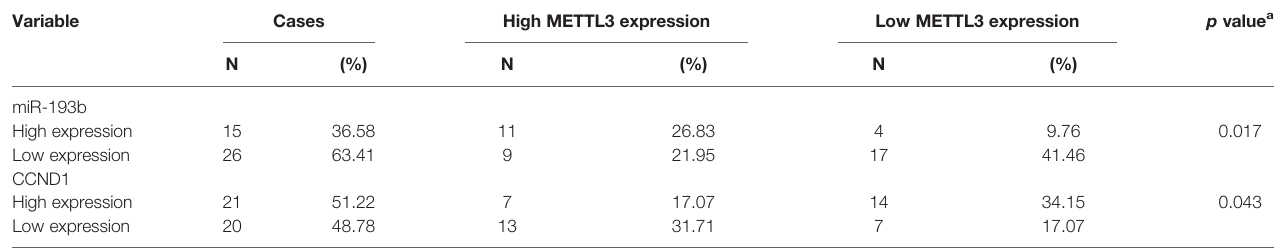
TABLE 3 | Relation among METTL3, miR-193b, and CCND1 in cervical cancer.